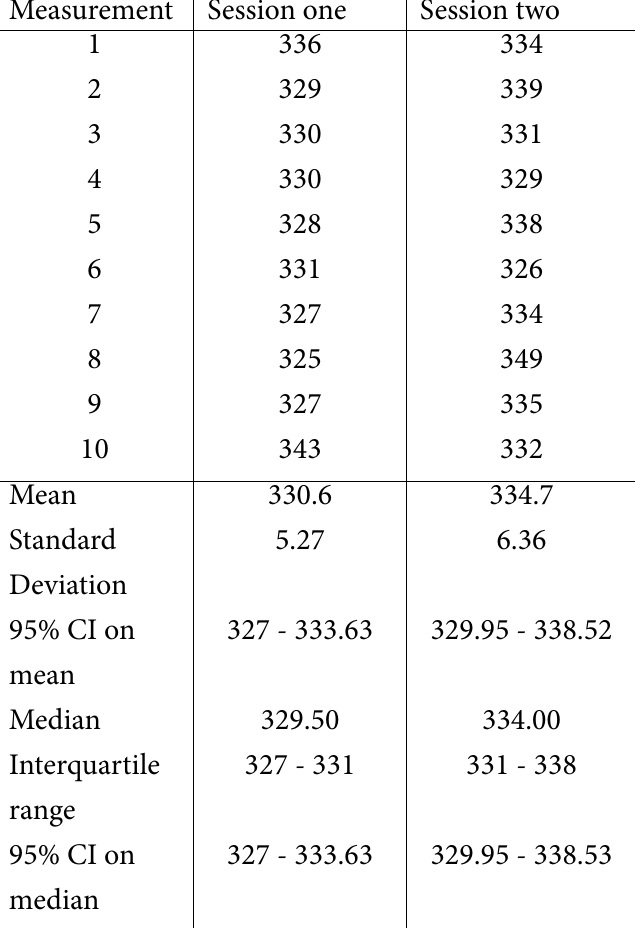
Table 1 . Tear osmolarity data collected during sessions one and two. All measurements are in mOsms/l.